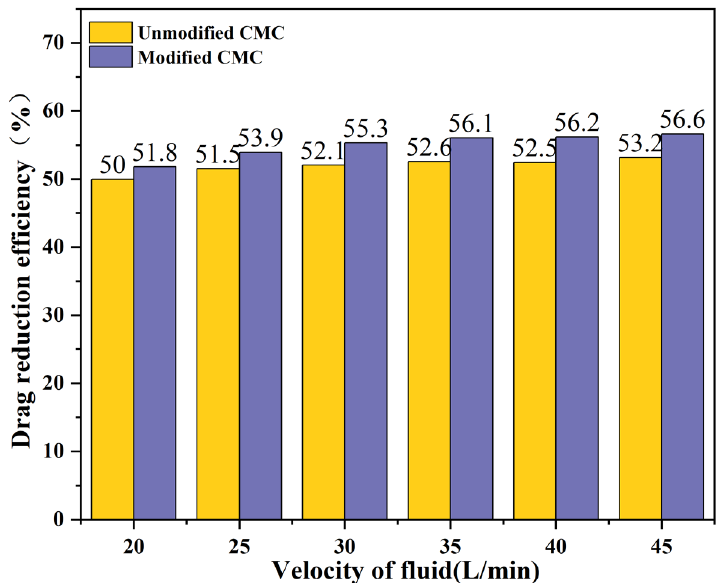
Figure 16. Comparison of drag-reduction rates of modified CMC and unmodified CMC at 0.03%. concentration and 6 velocity of fluid.